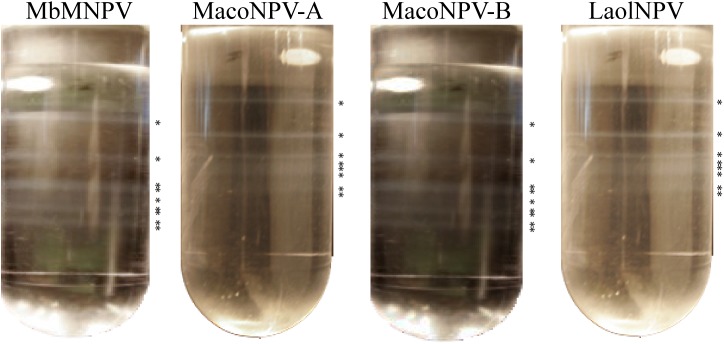
ODV banding patterns.ODV banding patterns of MbMNPV, MacoNPV-A, MacoNPV-B and LaolNPV after continous sucrose grandient separation. Asterisks indicate the position of the different visible bands.